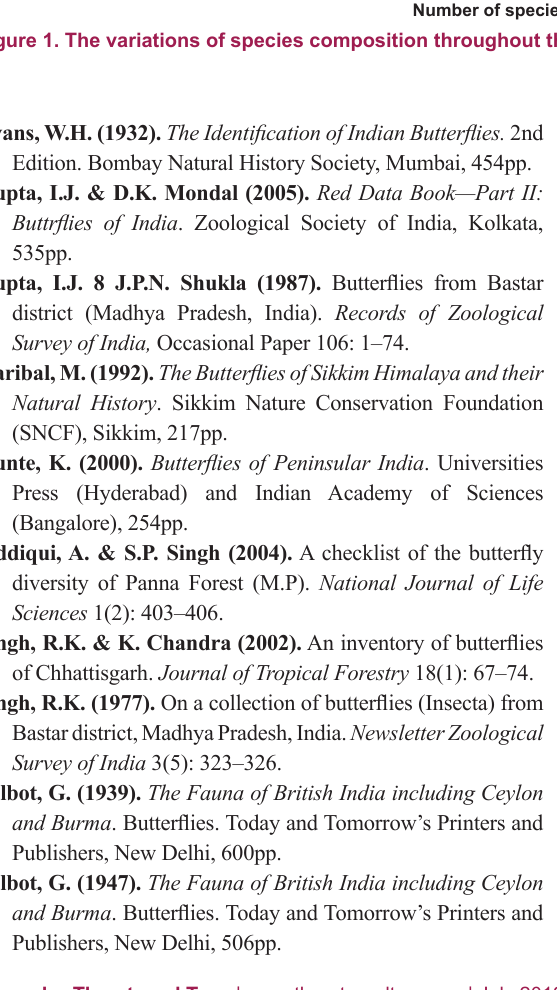
Number of species